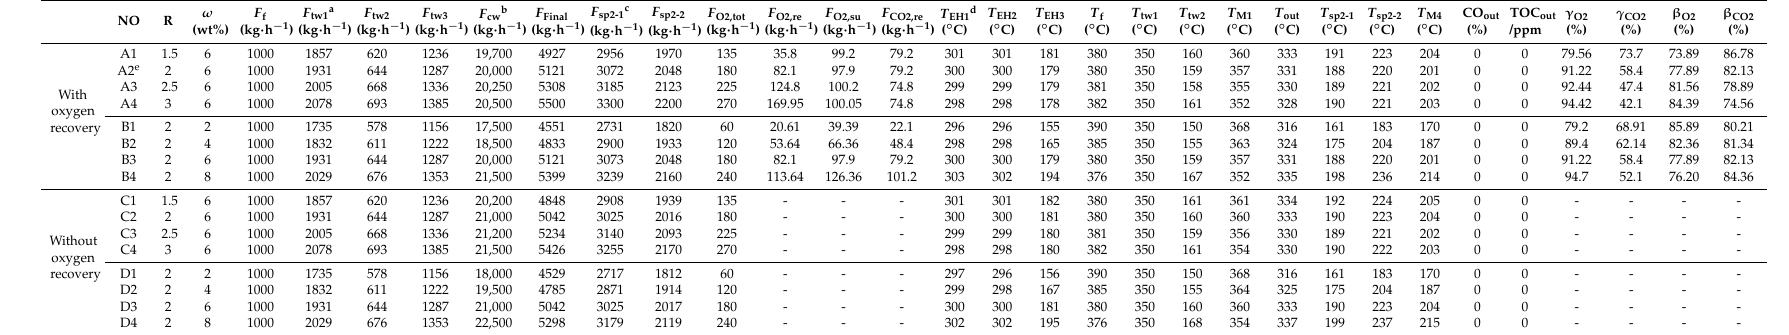
Table 3. The operating parameters for the SCWO systems with and without oxygen